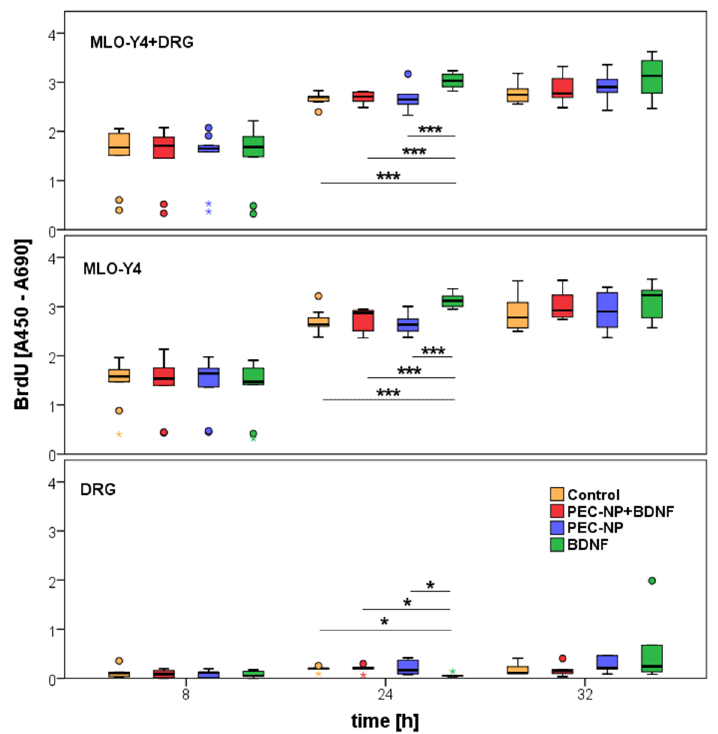
Figure 3. Proliferation increased in cocultures of MLO-Y4+DRG as well as in single culture of MLO- Y4 24 h after addition of BDNF, PECNP and PECNP+BDNF compared to cells without application of supplements whereas in cultures of pure DRG a reduction in proliferation was measured after application of pure BDNF. After incubation time of 8 and 32 h no significant differences in proliferation were measured by BrdU assay. One asterisk (*) indicates a statistically significant likelihood of p ≤ 0.05 and three asterisks (***) of p ≤ 0.001. Circles and colored asterisks indicate